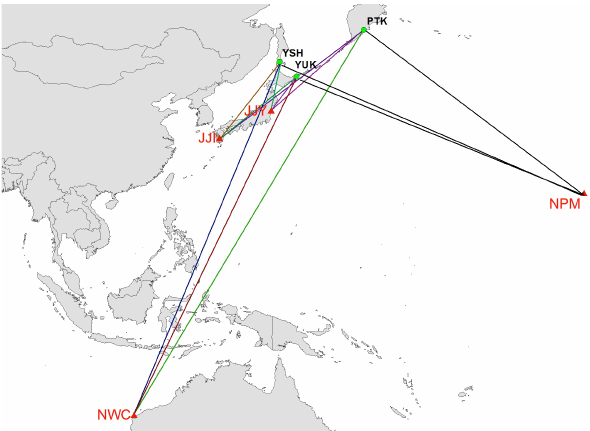
Figure 1. The map of the wave paths in the Far East network. The location of receivers in Petropavlovsk-Kamchatsky (PTK), Yuzhno- Sakhalinsk (YSH) and Yuzhno-Kurilsk (YUK) together with the position of the transmitters JJI (22.2kHz), JJY (40kHz), NWC (19.8kHz) and NPM (21.4kHz) are shown.